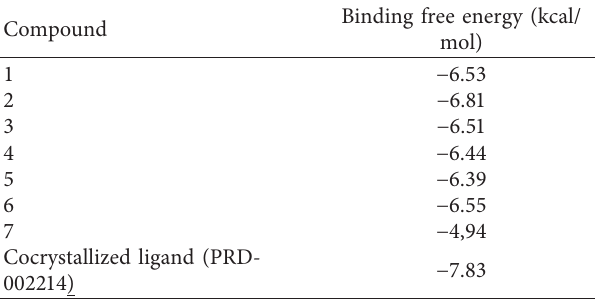
Figure 1: Chemical structures of the isolated compounds. Table 1: The docking binding free energies of seven compounds, simeprevir, and the cocrystallized ligand (PRD-002214) against COVID-19 main protease.